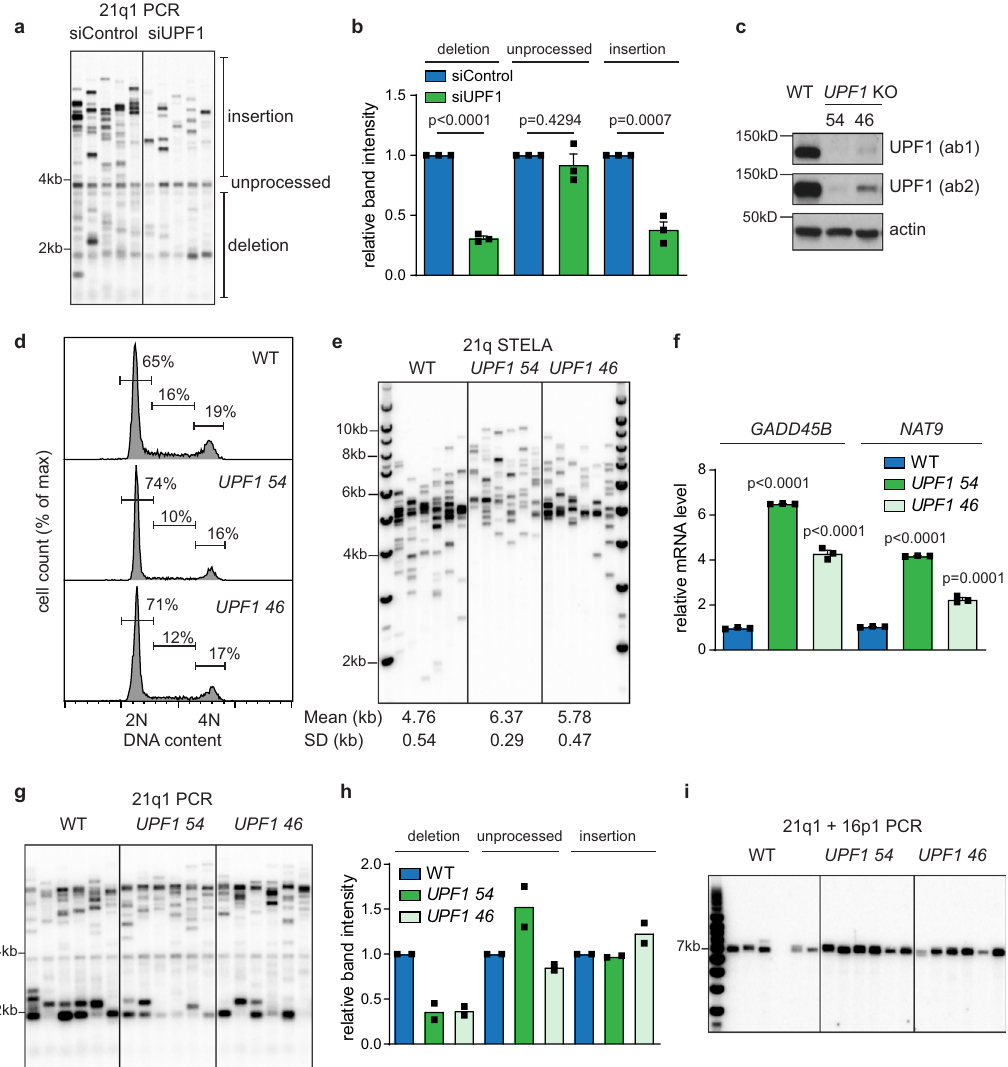
Fig. 2 UPF1 is involved in promoting telomere deletion. a 21q1 telomere fusion assay using DNA (50 ng) isolated from RPE1 cells transfected with UPF1 or control siRNAs 48 h after TALEN nucleofection. b Bar chart showing quanti fi cation of the intensity of fusion bands in siControl and siUPF1 (relative to the values in siControl). Data plotted are mean + SEM ( n = 3). p values were obtained using Student ’ s t -test (unpaired two-tailed, equal variance). c Western blot (a representative image from two independent experiments) showing the level of UPF1 (detected using two different antibodies ab1 or ab2) and actin in RPE1 WT or UPF1 KO cells. d Cell cycle analysis of RPE1 WT or UPF1 KO cells. e 21q STELA of RPE1 WT and UPF1 KO cells. A representative image from two independent STELA analysis was shown. f RT-qPCR analysis showing the mRNA level of two NMD markers GADD45B and NAT9 in WT or UPF1 KO cells. The values shown are relative to the values in WT and normalized with the mRNA level of GAPDH . Data plotted are means + SEM ( n = 3). p values were obtained using Student ’ s t -test (unpaired, two-tailed, equal variance). g 21q1 telomere fusion analysis using DNA (50 ng) isolated from RPE1 WT or UPF1 KO cells 48 h after nucleofection. h Bar chart showing quanti fi cation of the intensity of fusion bands in RPE1 WT or UPF1 KO cells (relative to values in WT). Data plotted are means ( n = 2). i 21q1 + 16p1 telomere fusion analysis using DNA (0.8 ng) isolated from RPE1 WT and UPF1 KO cells 48 h after nucleofection, with quanti fi cation of fusion bands from three independent experiments shown in Supplementary Fig. 2c. The n values indicate the number of independent experiments in all